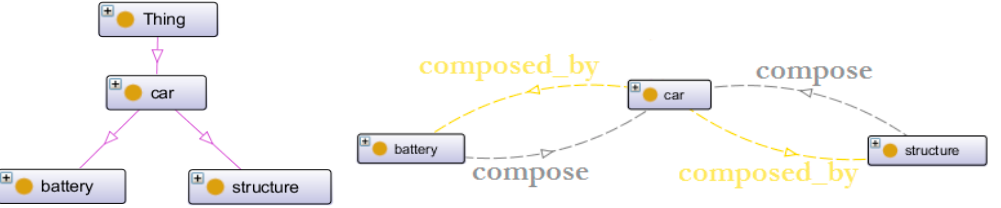
Figure 8. Overview of the car class and object properties.